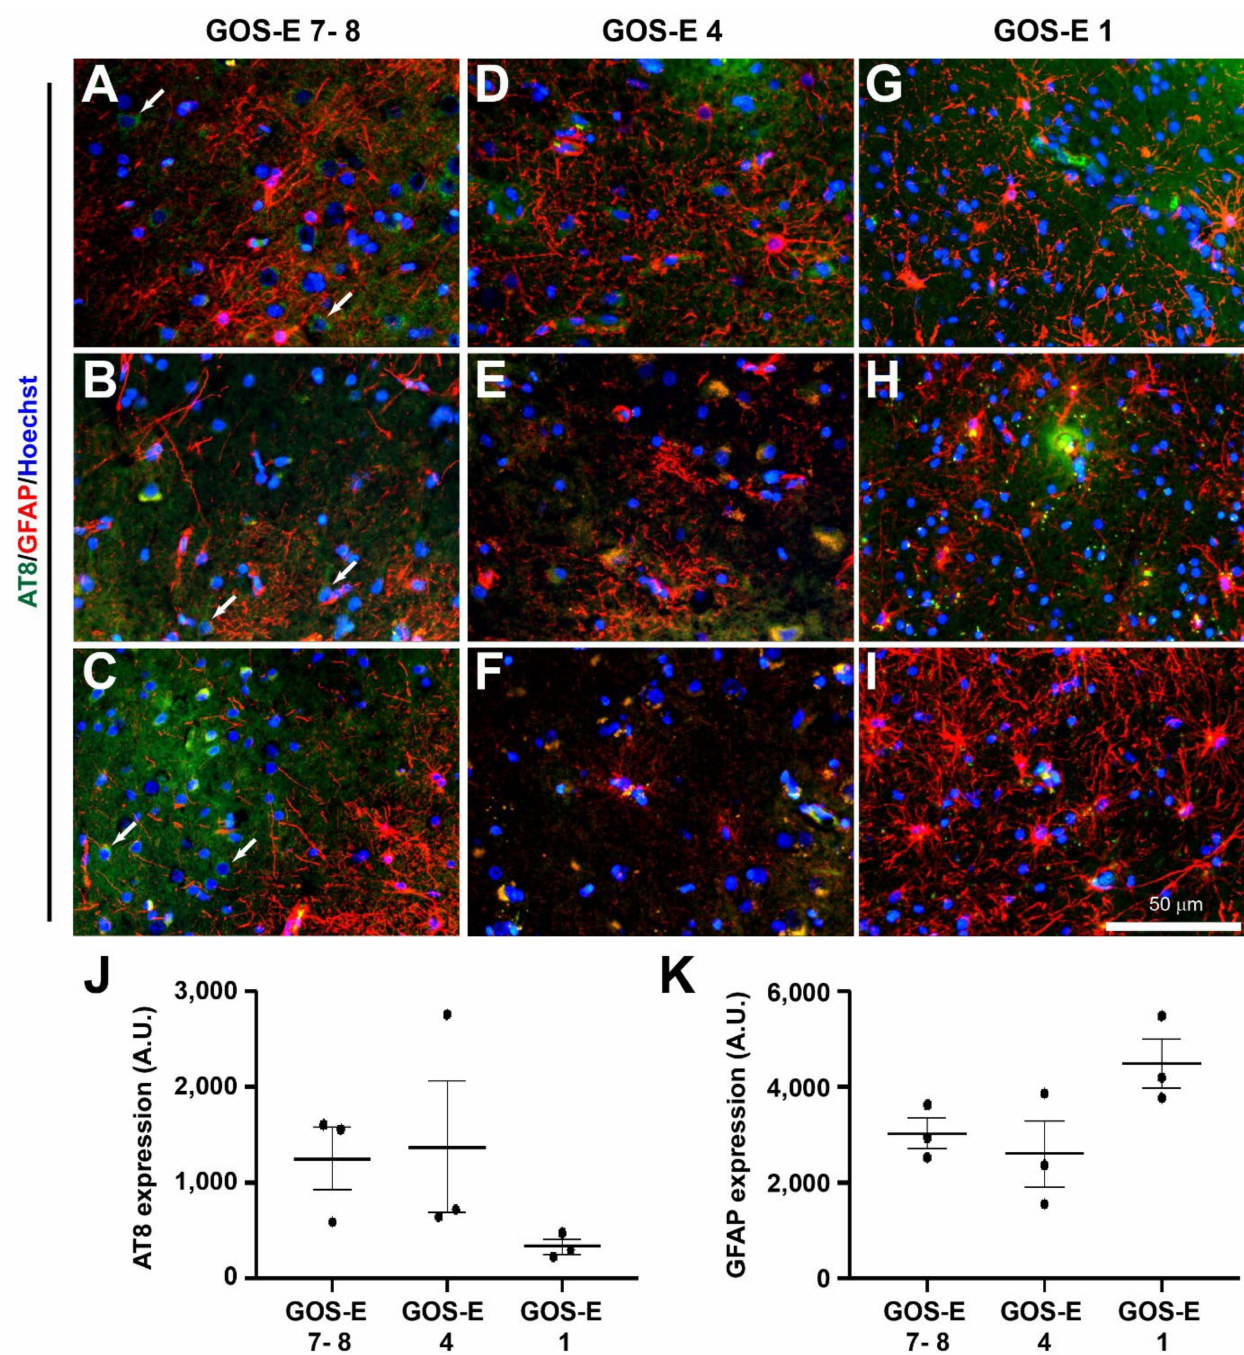
Figure 8. Tau phosphorylation and astrocytic-immunoreactivity in brain biopsies after severe TBI. Tau phosphorylation was stained using AT8 (green) and astrocytes was stained with GFAP (red). Photomicrographs of AT8 and GFAP immunostaining in 3 individual biopsies from patients with a GOS-E 7–8 ( A – C ). Photomicrographs of AT8 and GFAP immunostaining in 3 individual biopsies from patients with a GOS-E 4 ( D – F ). Photomicrographs of AT8 and GFAP immunostaining in 3 individual biopsies from patients with a GOS-E 1 ( G – I ). No significance between immunoexpression in the GOS-E groups was detected for AT8 ( J ) and GFAP ( K ). Results represent mean ± SEM. N = 3 per group. Scale bar 50 µ m. Cellular nuclei stained with Hoechst